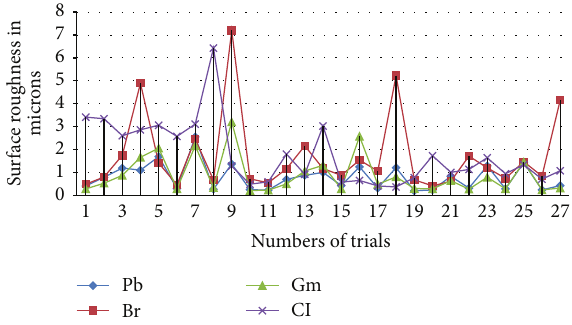
Figure 2: Surface roughness variations of brittle materials in microns.